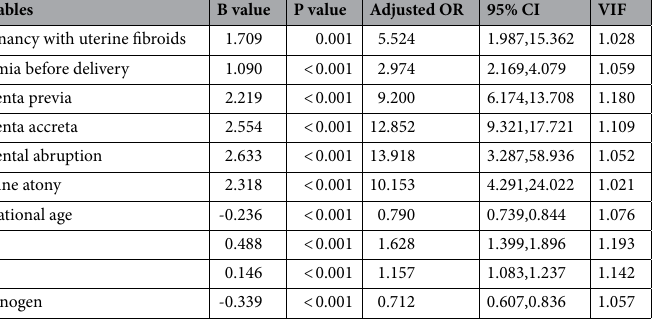
Table 2. Factors associated with CD-PPH in the training set. OR, odds ratio; 95% CI, 95% confidence interval; VIF, variance inflation factor.